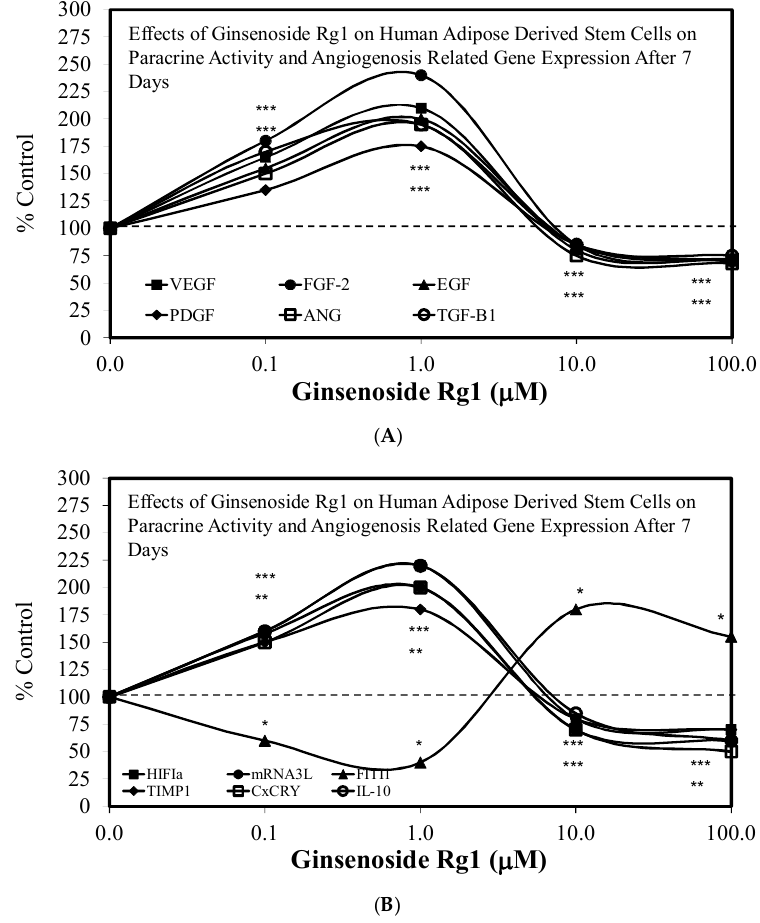
Figure 5. ( A ) Effects of ginsenoside Rg1 on human adipose-derived stem cells on paracrine activity and angiogenosis-related gene expression after 7 days (source: [34]). ( B ) Effects of ginsenoside Rg1 on human adipose-derived stem cells on paracrine activity and angiogenosis-related gene expression after 7 days (source: [34]). Each * represent statistical significance for a data point.